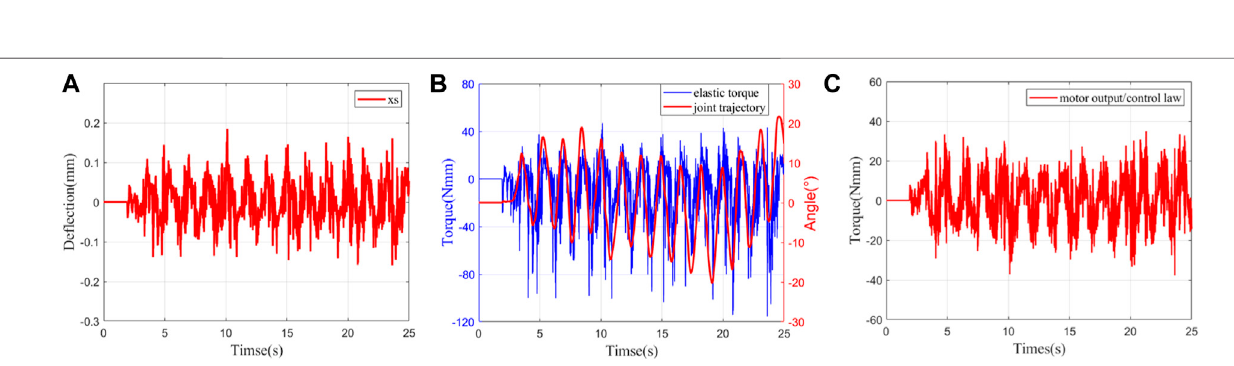
FIGURE 6 | Experimental results. (A) De fl ection trajectory tracking with fi xed output. (B) Motor output with fi xed output. (C) De fl ection trajectory tracking under zero-impedance control. (D) Elastic torque and joint trajectory under zero-impedance control. (E) Motor output/control law under zero-impedance control.